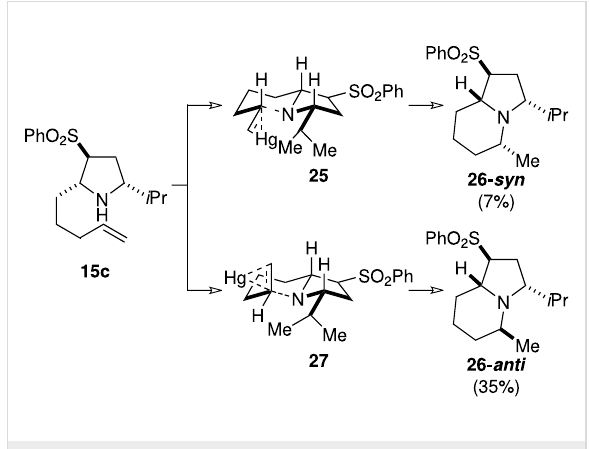
Scheme 7: Proposed transition state for mercury-mediate hydroamina-